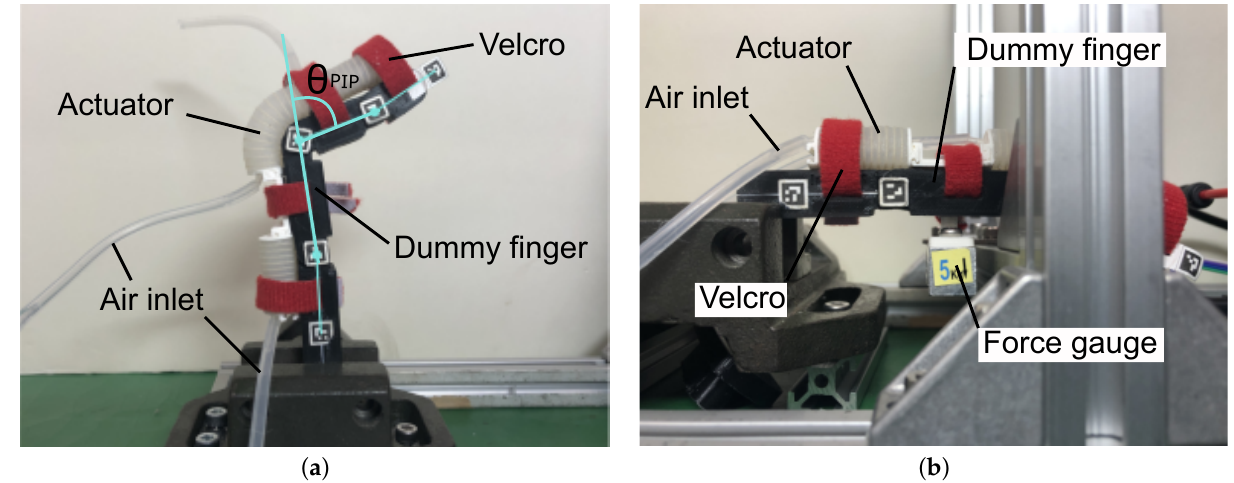
Figure 6. Experimental setup with actuator and dummy finger. ( a ) Joint ROM; ( b ) joint